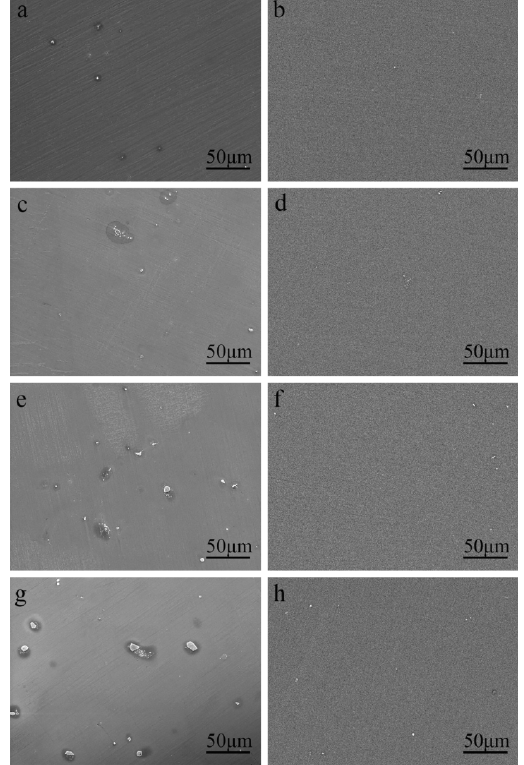
Figure 1. SEM micrographs of ( a , c , e , g ) as-cast Mg–xAl (x = 1, 2, 3, 4) alloys and ( b , d , f , h ) solution treated Mg–xAl (x = 1, 2, 3, 4) alloys.